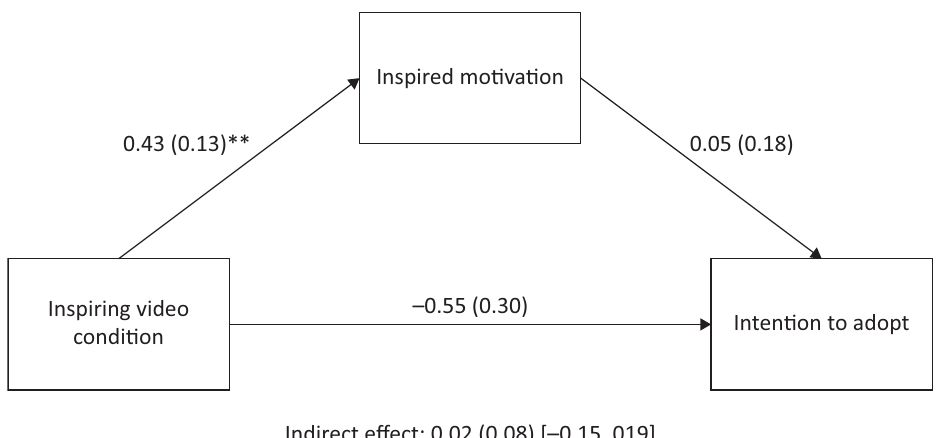
Figure 1. Mediated effect of inspiring videos on intention to adopt through inspired motivation. Notes: * p ≤ 0.05, ** p ≤ 0.01. Coefficients associated with each path presented as b (SE). Model statistics: Step 1— F (1, 161) = 11.14, p = 0.001, adj. R 2 = 0.06; Step 2— F (2,160) = 1.73, p = 0.18, adj. R 2 = 0.01.